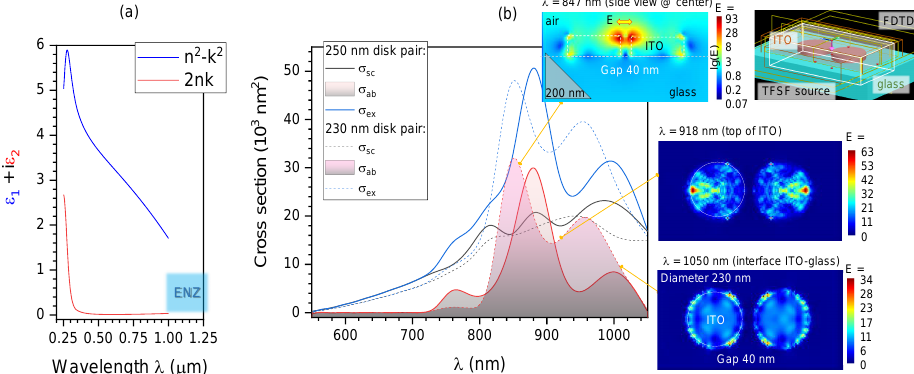
Figure 7. Numerical modeling of light intensity on an ITO metasurface consisting of nano-disk pairs. ( a ) Permittivity ˜ ε ≡ ε 1 + i ε 2 ≡ ( n + ik ) 2 of ITO [36]. The epsilon-near-zero (ENZ) region 0 < ε 1 < 1 is the near-IR spectral region. ( b ) Cross-sections of scattering, absorption and extinction σ ex ≡ σ ab + σ sc for a pair of ITO nanodisks calculated for 250 nm and 230 nm diameters using a total-field scattered-field (TFSF) source in Lumerical. Refractive index of glass n = 1.4, the height of disk h = 80 nm, gap 40 nm. Insets show characteristic light enhancement maps at different cross-sections and wavelengths. Linear polarisation of light was aligned perpendicular to the